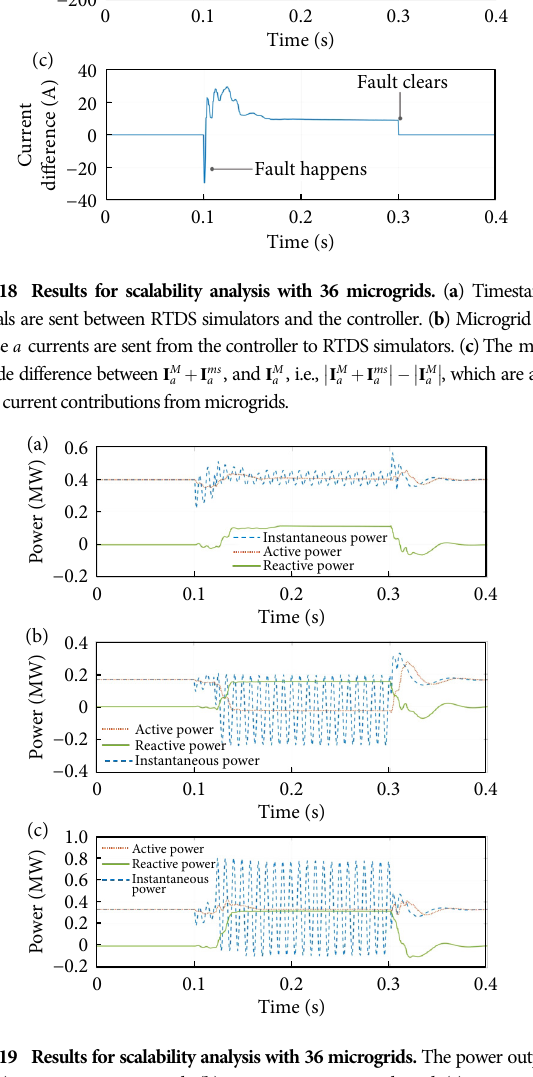
Fig. 19 Results for scalability analysis with 36 microgrids. The power output of ( a ) one type 1 microgrid, ( b ) one type 2 microgrid, and ( c ) one type 3 microgrid, including instantaneous power, active power, and reactive